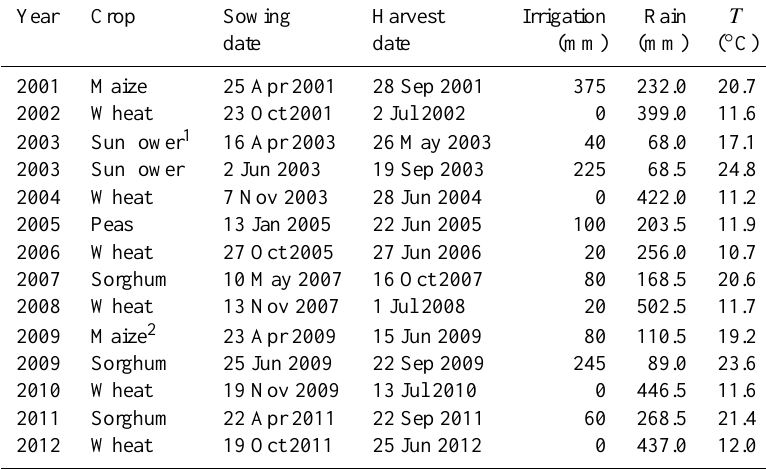
temperature and cumulative precipitation, respectively, over the crop cycle.